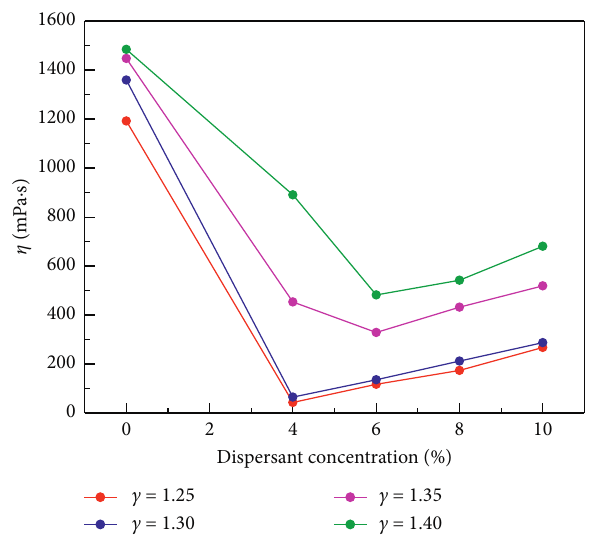
Figure 11: Relationship between the viscosity of the suspension and dispersant concentration.